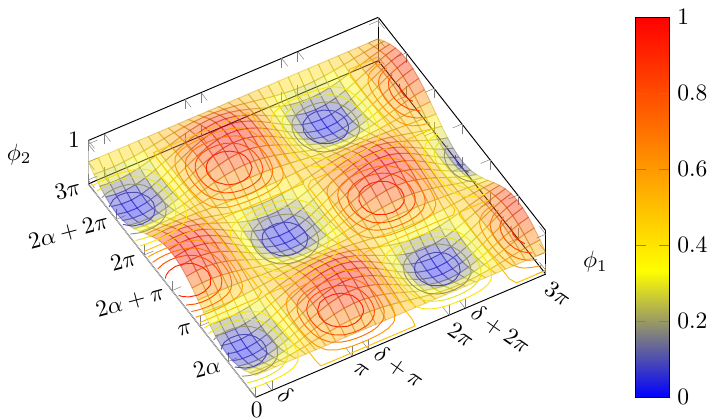
Figure 9. Plot of P L ( φ 1 , φ 2 ) for α = π /4 and δ = π /6. Note that now the surface displays a check